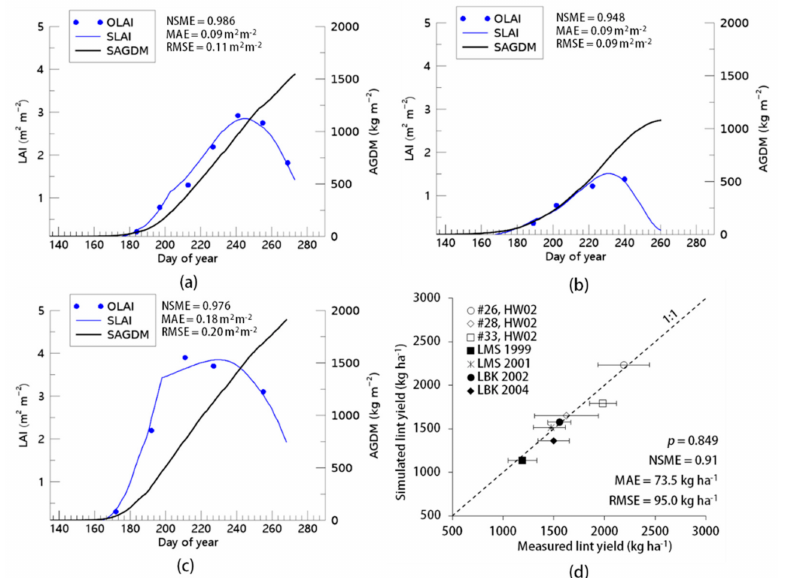
Figure 4. Simulated and observed cotton growth from Texas, USA at ( a ) field #26 in Halfway, HW in 2002; ( b ) the Texas A&M University Agricultural Research field in Lamesa, LMS in 1999; and ( c ) the Plant Stress and Water Conservation Laboratory field in Lubbock, LBK in 2002. ( d ) Comparison between simulated and observed lint yields for all data from the study sites. OLAI, SLAI, and SAGDM represent observed leaf area index, simulated leaf area index, and simulated above-ground dry mass, respectively. #26, #28, and #33 represent cotton field